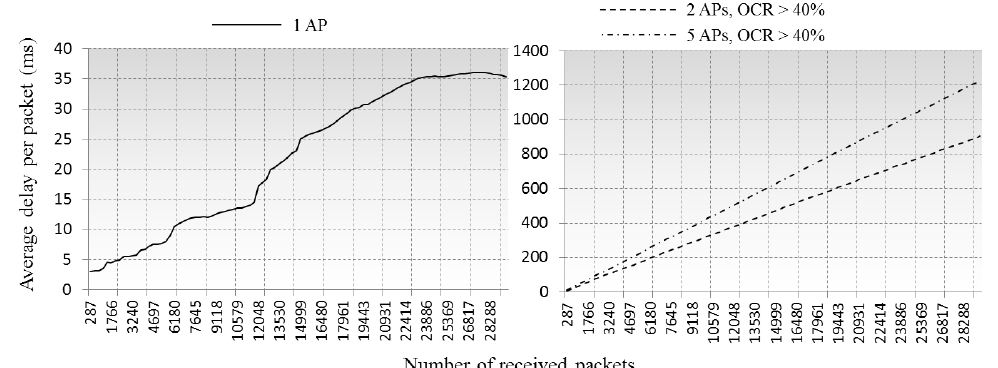
Figure 7. Comparison of averaged transmission delay of arrived packets.